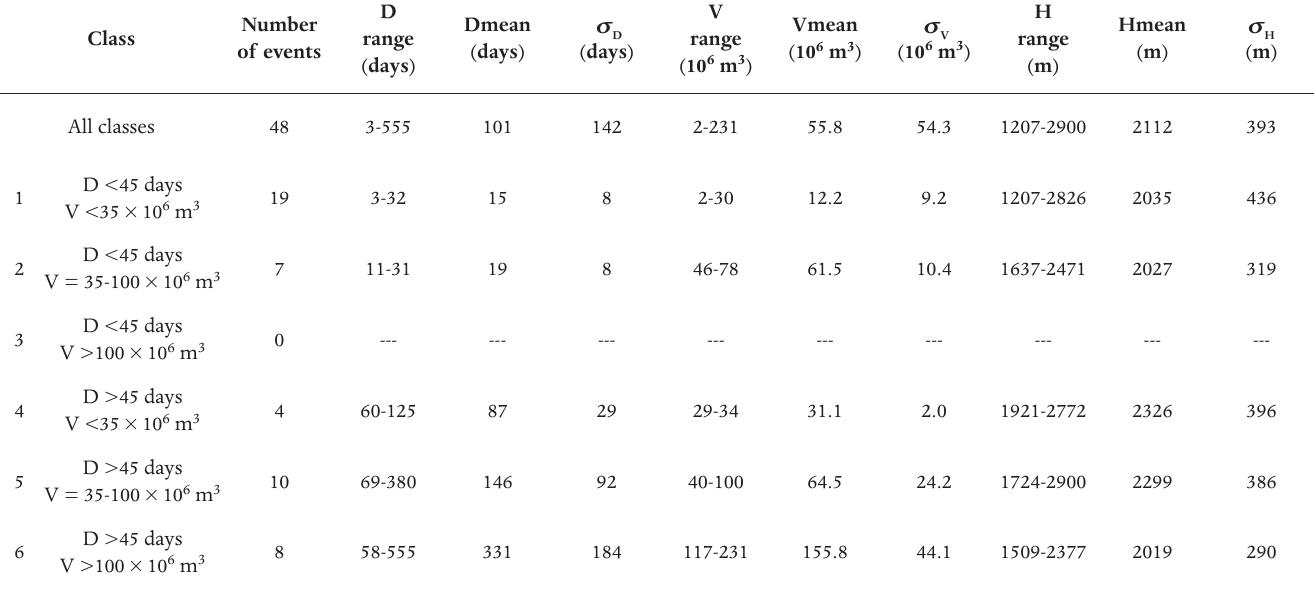
Table 1. Number of events, ranges, means and standard deviations ( v ) of the durations (D), volumes (V) and elevations of the main vent (H) for each class.